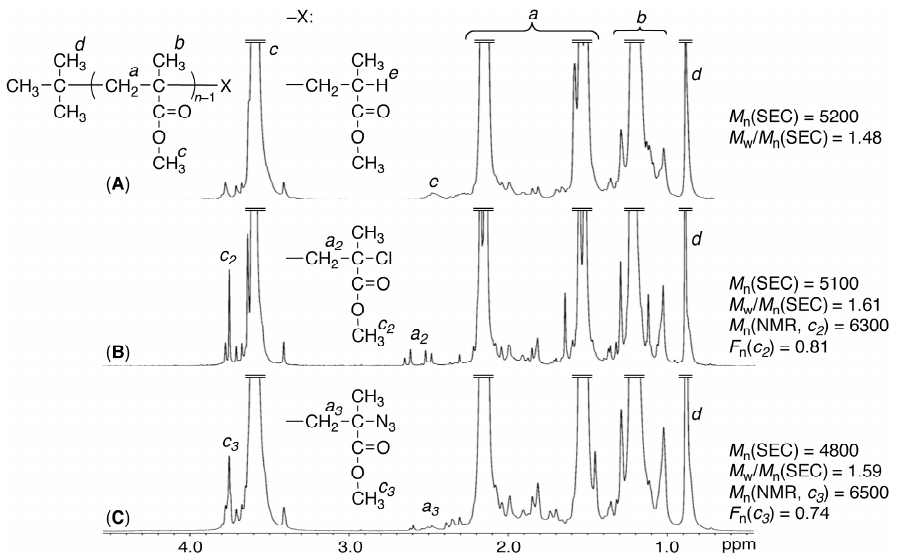
Figure 2. 1 H NMR spectra (in CDCl 3 at 55 °C) of it -50-PMMAs obtained in anionic polymerization of MMA with t -BuMgBr in toluene at − 78 °C and subsequent procedures: ( A ) Quenching the polymerization ([M] 0 /[ t -BuMgBr] 0 = 1350/27) with acidic methanol; ( B ) Quenching the polymerization with CCl 4 /DBU ([M] 0 /[ t -BuMgBr] 0 /[CCl 4 ] add /[DBU] add = 1350/27/1080/270) followed by reprecipitations; ( C ) Azidation with NaN 3 /CuCl/CuCl 2 /bpy in CH 3 CN/H 2 O = 9/1 at 40 °C ([–Cl] 0 /[NaN 3 ] 0 /[CuCl] 0 /[CuCl 2 ] 0 /[bpy] 0 = 10/100/6.5/4.3/22 mM).